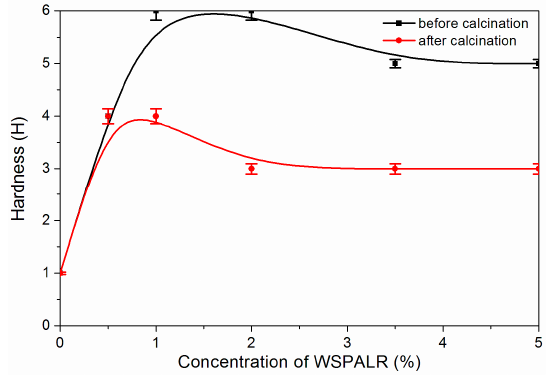
Figure 6. Effect on WSPALR and high-temperature calcined WSPALR on the hardness of